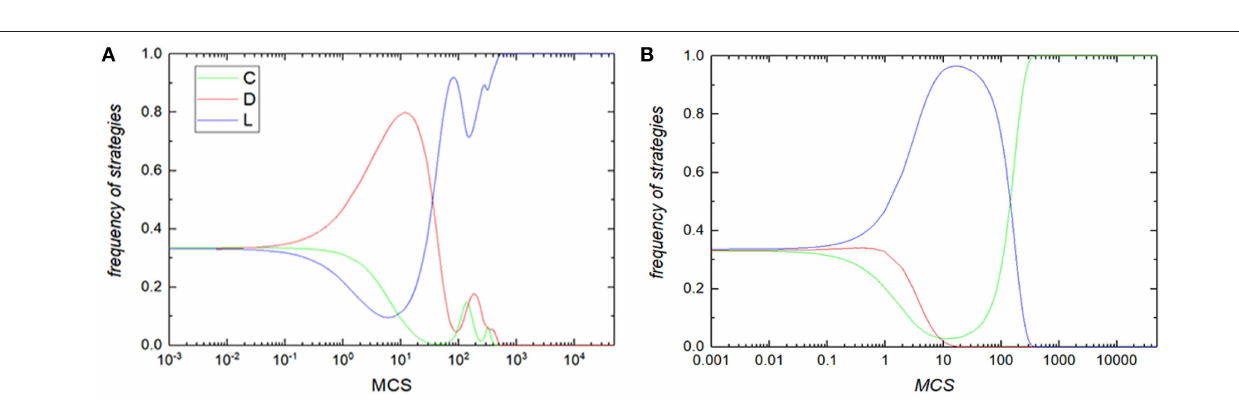
FIGURE 7 | Frequency of three strategies with the spacial structured population at each time step under the small tiny benefit σ = 0.02 (A) and the large tiny benefit σ = 0.99 (B) under the reciprocal rewarding strength β = 0.0 in the voluntary PDG. In all panels, green, red, and blue curves correspond to cooperators, defectors, and loners, respectively. In all simulations, other parameters are set to be L = 100, MCS = 5 × 10 4 , b = 1.4, K =